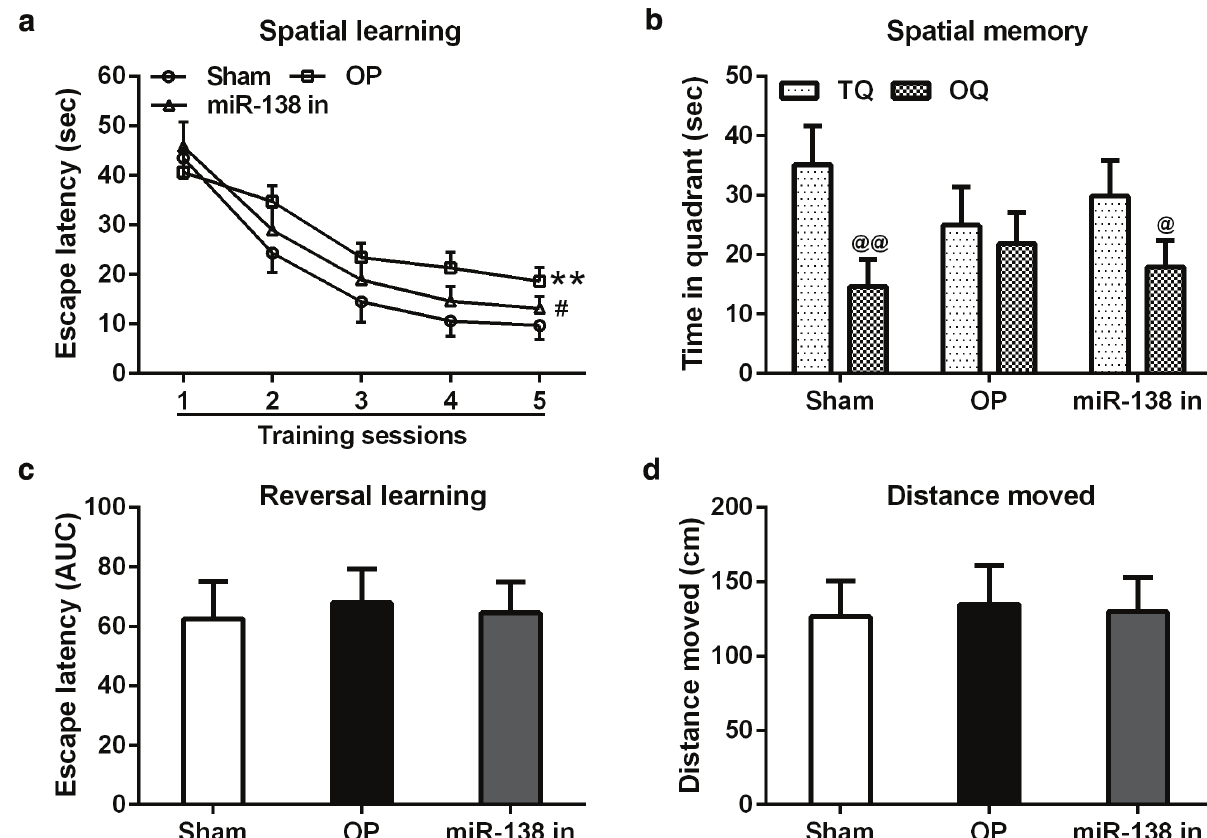
Fig. 3. Inhibition of miR-138-5p increased learning and memory of mice with cardiac surgery in Morris water maze test (MWM). (a) Spatial learning. Average escape latency (sec) is shown for the five training sessions. (b) Spatial memory after a short training period (three training sessions). The time spent in the target quadrant (TQ) and opposing quadrant (OQ) during the probe trial is depicted. (c) Cognitive flexibility. The area under the curve (AUC) for the escape latencies during the two rever- sal training sessions is shown. (d) Distance moved (m) during the MWM probe trial. Sham: C57BL/6 wild-type mice with sham cardiac surgery; OP: C57BL/6 wild-type mice with cardiac surgery. miR-138 in: C57BL/6 wild-type mice with cardiac surgery treated with miR-138-5p inhibitors. Data were presented as ± SD. ** P < 0.01 compared to sham group. # P < 0.05, compared to OP group. @ P < 0.05, @@ P < 0.01 compared to TQ. n = 8 for each